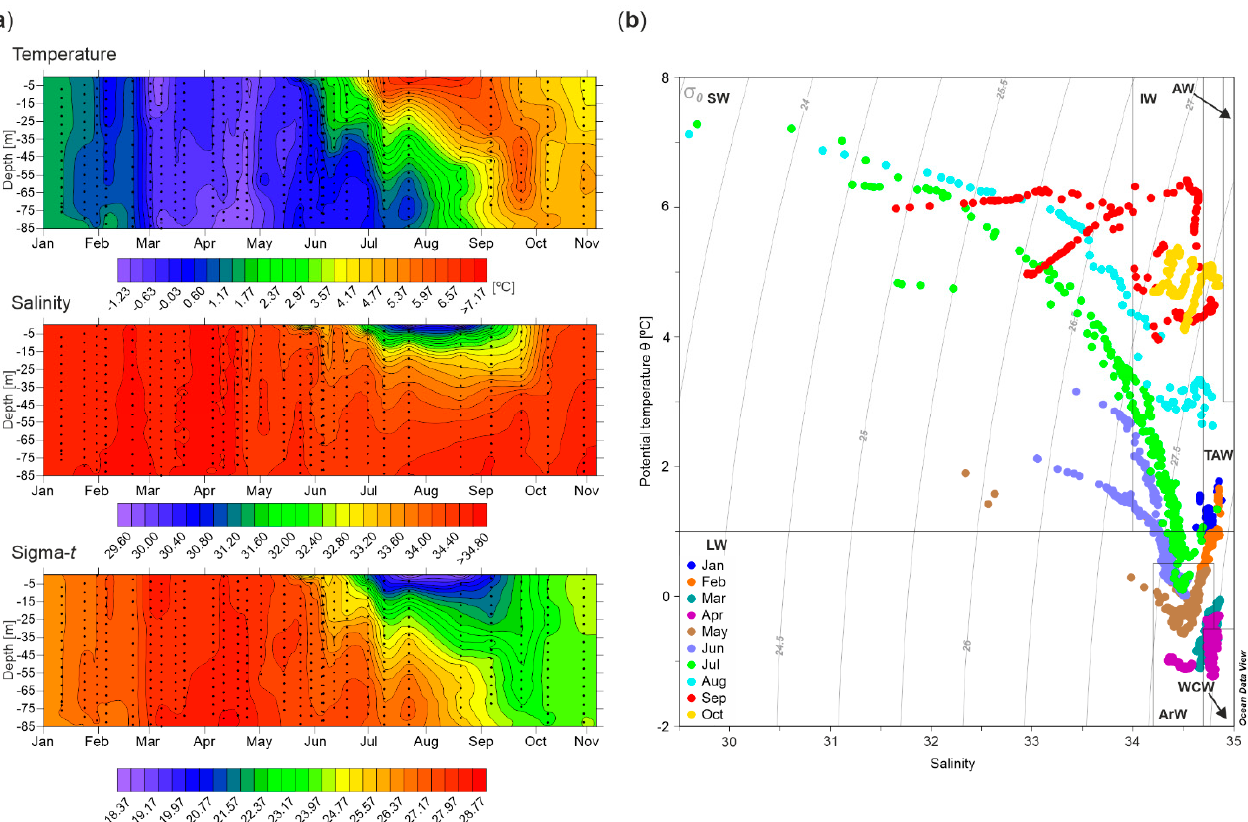
Figure 2. ( a ) Water temperature [°C], salinity and density (sigma- t ) profiles at the IsA station in 2013. The individual measurements are marked with dots (measurement marking frequency every 5 m; similar symbols are used in Figure 3); ( b ) temperature-salinity (TS) diagram based on all conductivity-temperature-depth (CTD) profiles by sampling month.